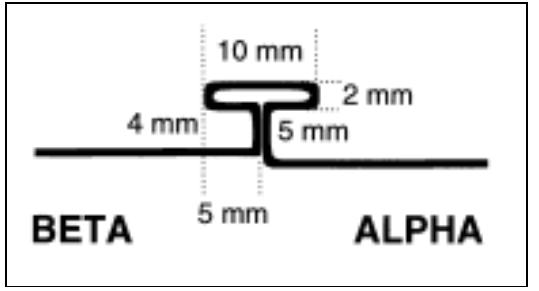
Figure 6: Burstone T-loop